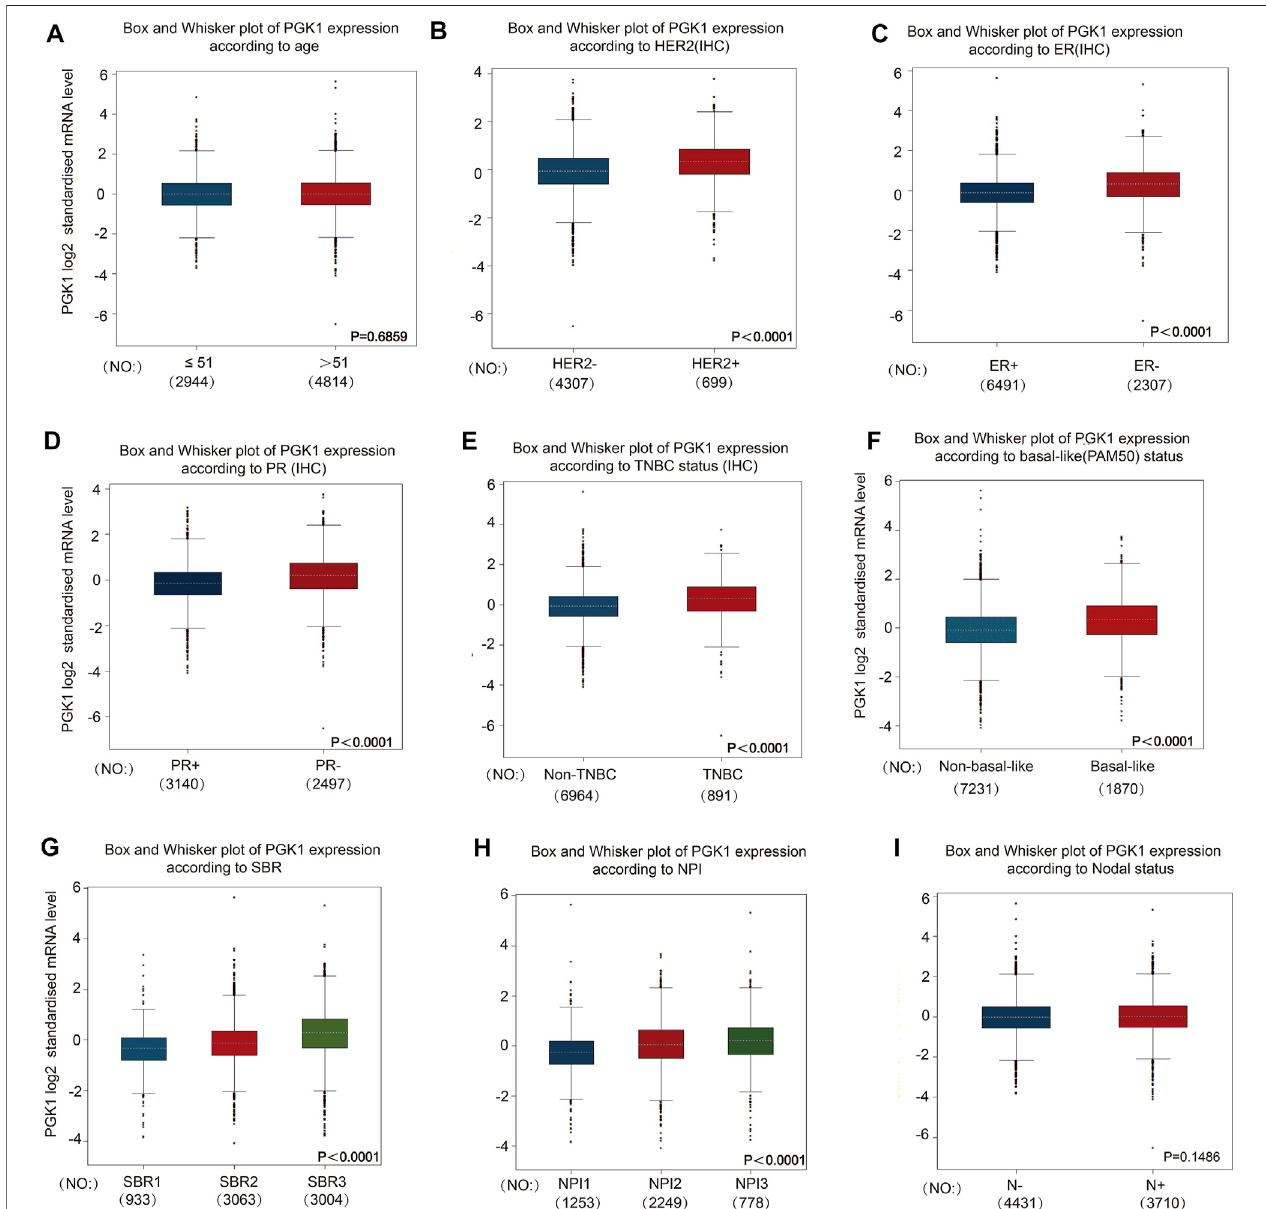
FIGURE5| TostudythecorrelationofPGK1expressionwithclinicalpathologicalparametersincludingage (A) ,HER2 (B) ,ER (C) ,PR (D) ,TNBCstatus (E) ,basal- like (PAM50) status (F) , SBR (G) , NPI (H) and Nodal status (I) in breast cancer patients. Notable differences between the groups were analyzed by Welch ’ s t -test to generate the p -value. PGK1, phosphoglycerate kinase 1; ER, estrogen receptor; PR, progesterone receptor; HER2, human epidermal growth factor receptor 2; SBR, Scarff, Bloom and Richardson; TNBC, Triple-negative Breast Cancer; NPI, Nottingham Prognostic Index status; IHC, immunohistochemistry.